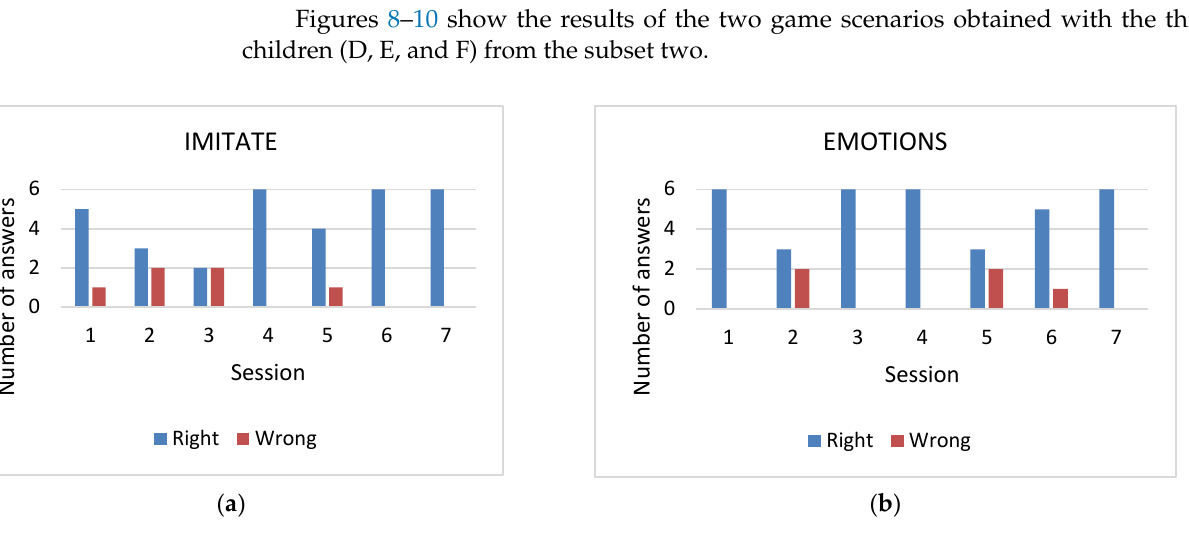
Figure 8. Child D results — On ( a ), the progress over seven sessions with the IMITATE activity. On ( b ), the progress over seven sessions with the EMOTIONS activity.